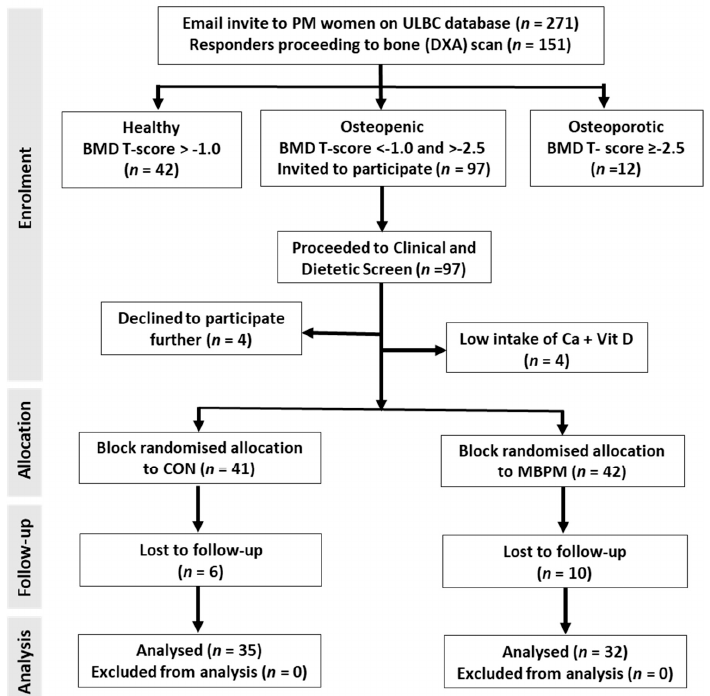
Figure 1. CONSORT flow diagram of participant enrolment, allocation, follow-up, and analysis.